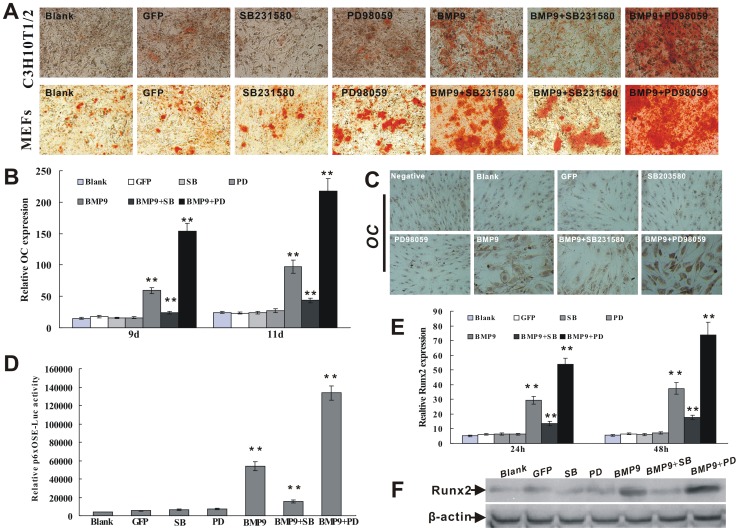
Opposing effects of p38 and ERK1/2 on BMP9-induced late osteogenic differentiation and Runx2 activation in MPCs.(A) Opposing effects of p38 and ERK1/2 on BMP9-induced matrix mineralization of MPCs. C3H10T1/2 cells and MEFs were infected with Ad-BMP9 or Ad-GFP, and then treated with SB203580 (25 mM) or PD98059 (10 mM). At day 21, cells were subjected to Alizarin Red S staining. Magnification, ×200. (B) qPCR analysis of SB203580 and PD98059 on BMP9-induced osteocalcin expression at gene level. C3H10T1/2 cells were infected with Ad-BMP9 or Ad-GFP, and then treated with SB203580 (25 mM) or PD98059 (10 mM). At day 9 and day 11, osteocalcin expression was detected by qPCR. All samples were normalized using endogenous levels of β-actin. “**”, p<0.01 (vs. control groups). (C) Immunocytochemical staining analysis of SB203580 and PD98059 on BMP9-induced osteocalcin expression at protein level. C3H10T1/2 cells were infected with Ad-BMP9 or Ad-GFP (MOI = 5), and then treated with SB203580 (25 mM) or PD98059 (10 mM). At day 12, cells were fixed and subjected to immunocytochemical staining analysis. Magnification, ×200. (D) Opposing effects of p38 and ERK1/2 on BMP9-induced Runx2 transcriptional activity. C3H10T1/2 cells were transfected with OC promoter containing Runx2-responsive element reporter, p6xOSE-Luc. Next, cells were infected with Ad-BMP9 in the presence of SB203580 (25 mM) or PD98059 (10 mM). At 36 hrs post infection, cells were lyzed for luciferase activity assay. Each assay condition was carried out in triplicate in at least two independent batches. Luciferase activity was normalized by total cellular protein concentrations among the samples. “**”, p<0.01 (vs. control groups). (E) qPCR analysis of SB203580 and PD98059 on BMP9-induced Runx2 expression at gene level. C3H10T1/2 cells were infected with Ad-BMP9 or Ad-GFP, and then treated with SB203580 (25 mM) or PD98059 (10 mM). At 24 and 48 hrs post treatment, Runx2 gene expression was detected by qPCR. Each assay condition was carried out in triplicate. All samples were normalized by endogenous level of β-actin. “**”, p<0.01 (vs. control groups). (F) Western blotting analysis of SB203580 and PD98059 on BMP9-induced Runx2 expression at protein level. C3H10T1/2 cells were infected with Ad-BMP9 or Ad-GFP, and then treated with SB203580 (25 mM) or PD98059 (10 mM). At 48 hrs post treatment, Runx2 protein expression was detected by western blotting. β-actin was used to demonstrate equal loading of all samples.